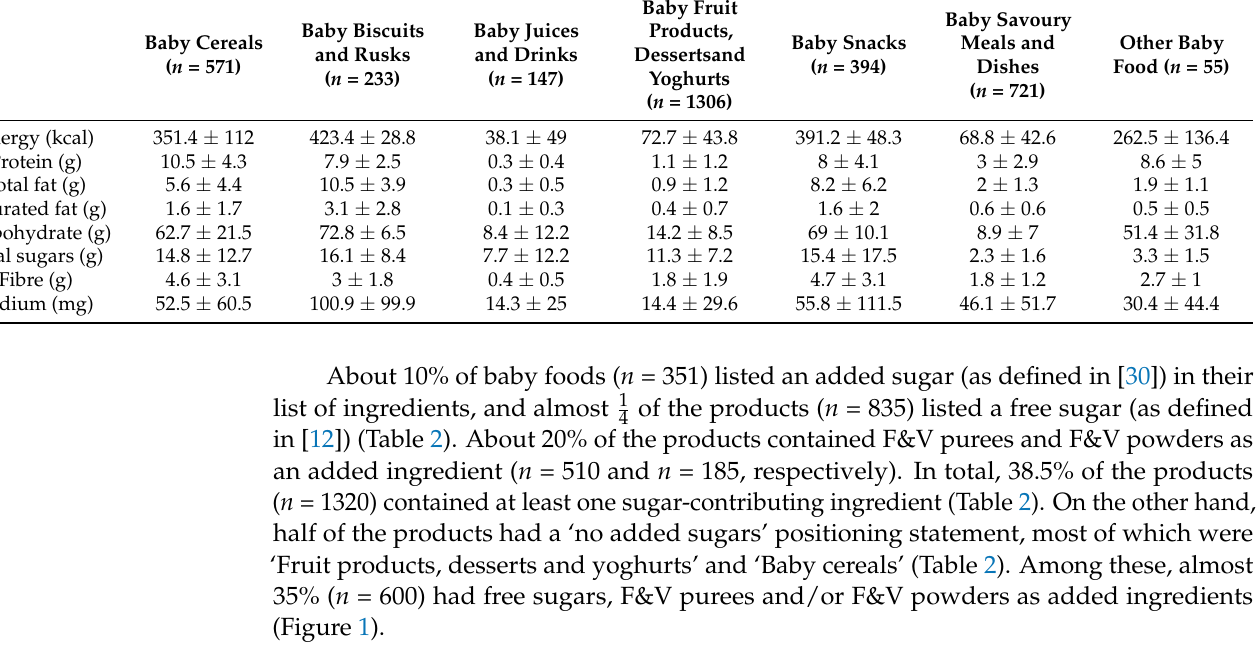
Table 1. Energy and nutrient content (mean ± s.d.) per 100 g of 3427 foods for infants and young children from 24 EU countries, Norway, Switzerland and the UK.